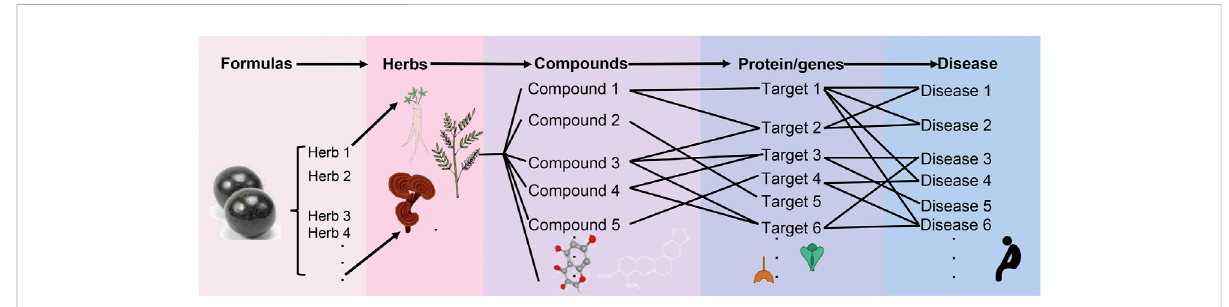
FIGURE 3 TCM network pharmacology analysis is proposed for leveraging the “ ingredients-compounds-proteins/genes-diseases ” network for TCM research. A TCM formula is made according to the Chinese Pharmacopoeia, herbal ingredients were the major prescribed ingredients in most TCM formulas. While based on network pharmacology analysis, chromatography, and high-throughput sequencing technology, we could decode the relationship between TCM formulas-species ingredients-compounds-targets-diseases. By looking at the bioactive compounds in the prescribed ingredients, we could learn more about the herb, the bioactive compounds, the target proteins, and the genes in treating diseases. This would help us understand how TCM works to treat different